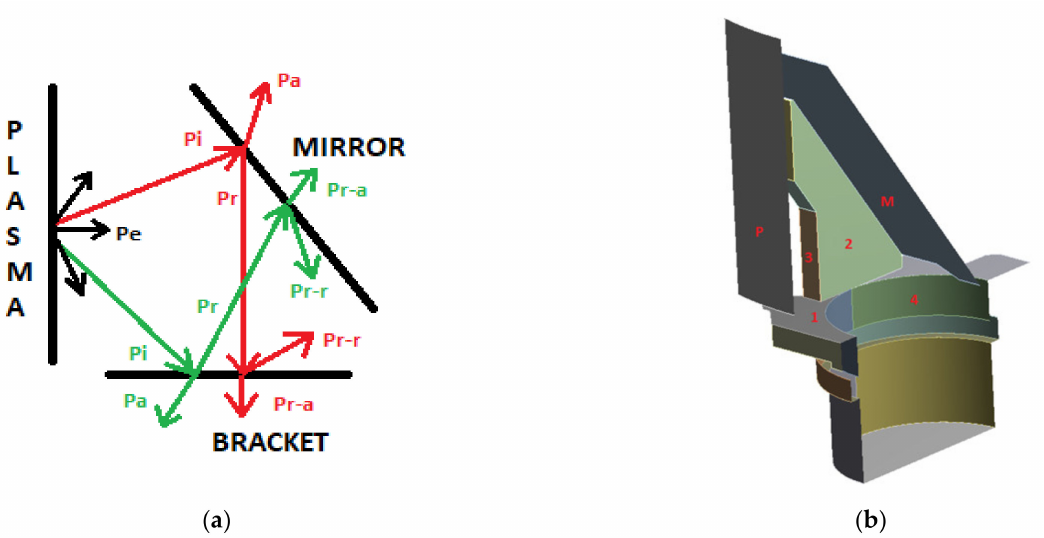
Figure 7. ( a ) Heat balance on each face—Pe indicates the heat flux radiation emitted by the plasma. Pi, Pr and Pa represent respectively the incident, reflected and absorbed heat flux radiation on the component surface. ( b ) Symmetrical representation of the area of study—P represents the opening (hence the plasma), M indicates the mirror face and numbers 1 to 4 point to several surfaces of the